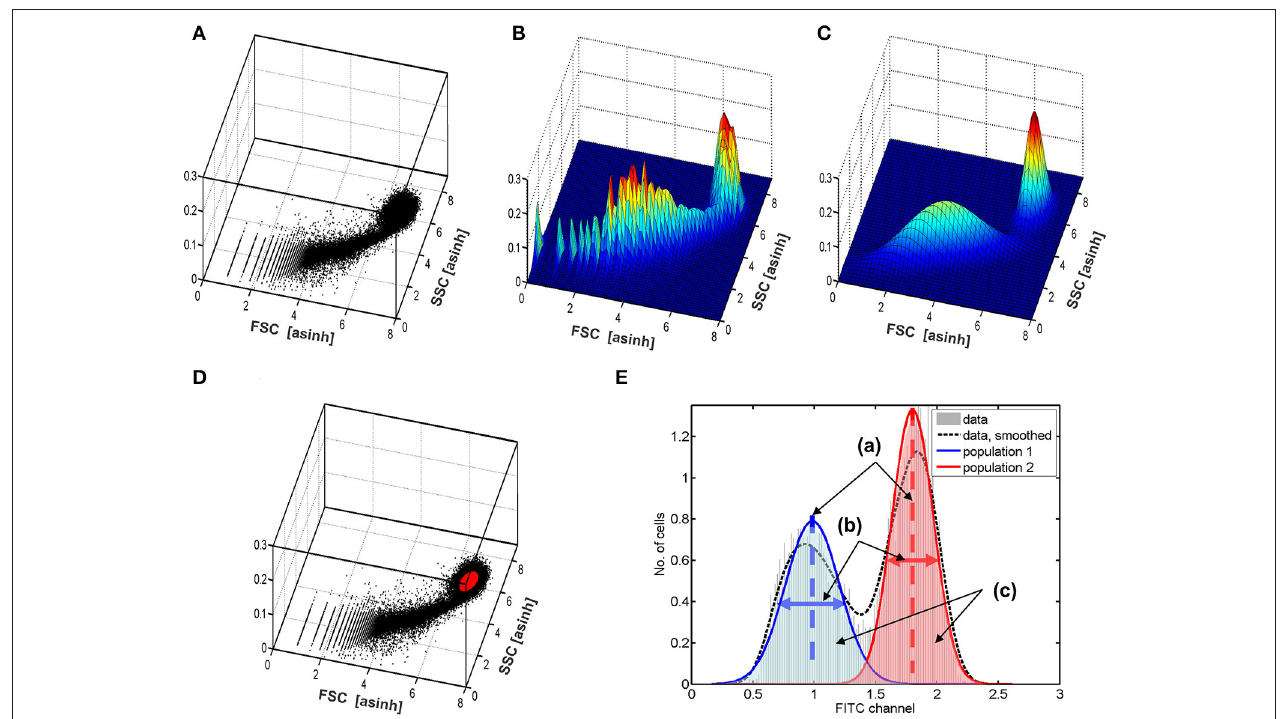
FIGURE 6 | Demonstration of the data processing based on mixture models. Panel (A) shows the measurements as a scatterplot of forward vs. side-scatter signals. Panel (B) shows the same as a 2D histogram. The fitted Gaussian mixture model is plotted in (C) . Based on this fit, the cells are selected based on thresholds. One outcome, i.e., the selected cells are shown in (D) in red color. To obtain robust results, the outcomes are averaged over alternative reasonable data processing strategies using other data transformations (asinh and log) and thresholds. Panel (E) illustrates the obtained five numbers estimated for each data set from the histogram of the FITC channel: (a) two estimates of the average amount of insulin binding for the two groups of cells (dashed lines); (b) two variances for the two observed cell groups (horizonal arrows); (c) the proportion of cells in the two groups of cells, which can be calculated from the areas in both